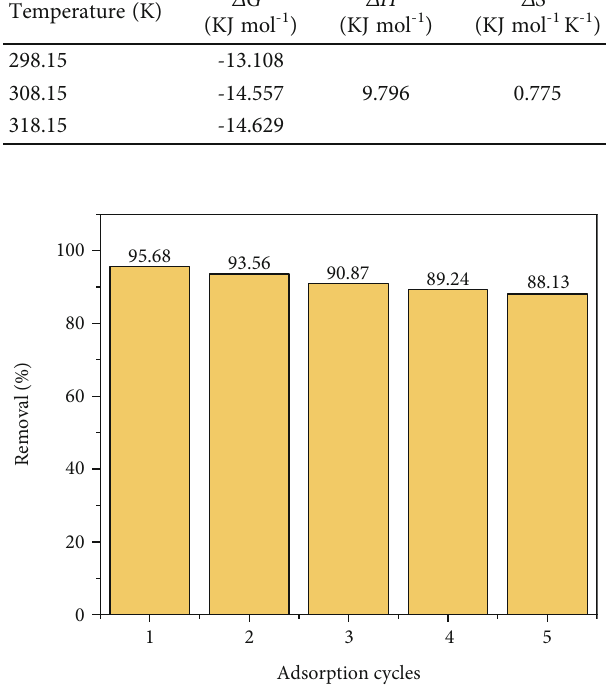
Figure 6: CIP removal e ffi ciency of MBC per each usage